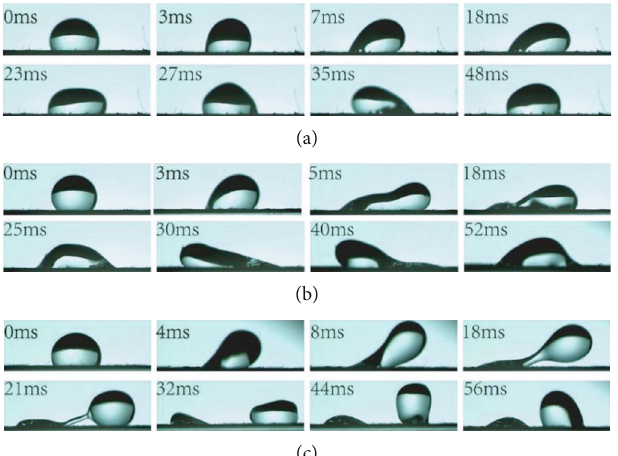
Figure 9: Under the horizontal vibration frequency of 20 Hz, di ff erent amplitude conditions, the movement of droplets on the surface of GDL.